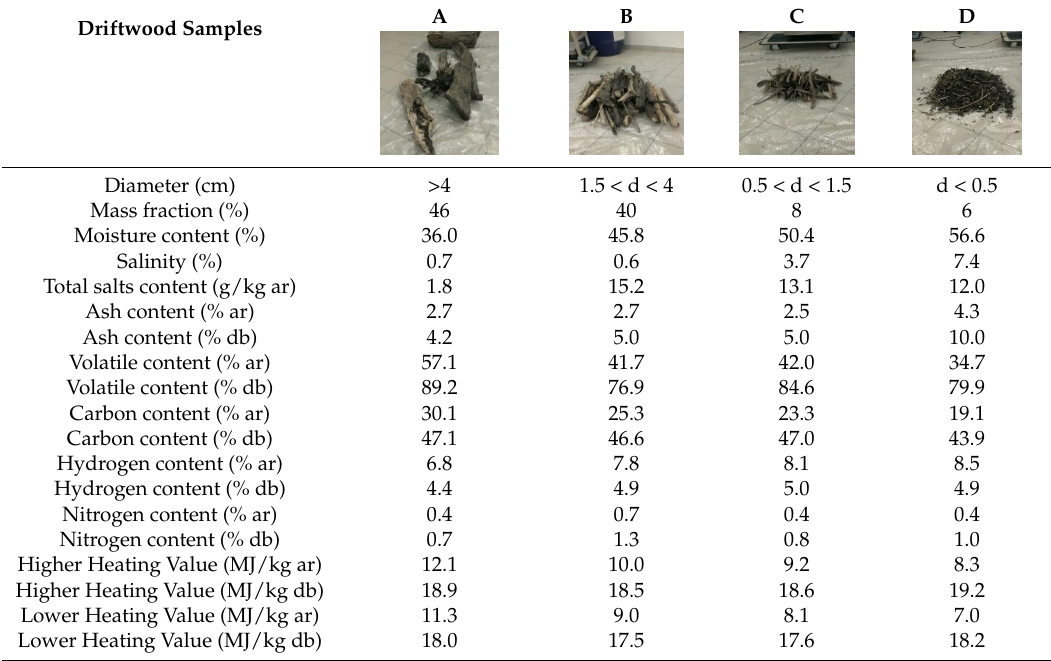
Figure 1. ( a ) Stranded driftwood residues; ( b ) The study area. Table 1. Physico-chemical characteristics of the biomass [39–43].